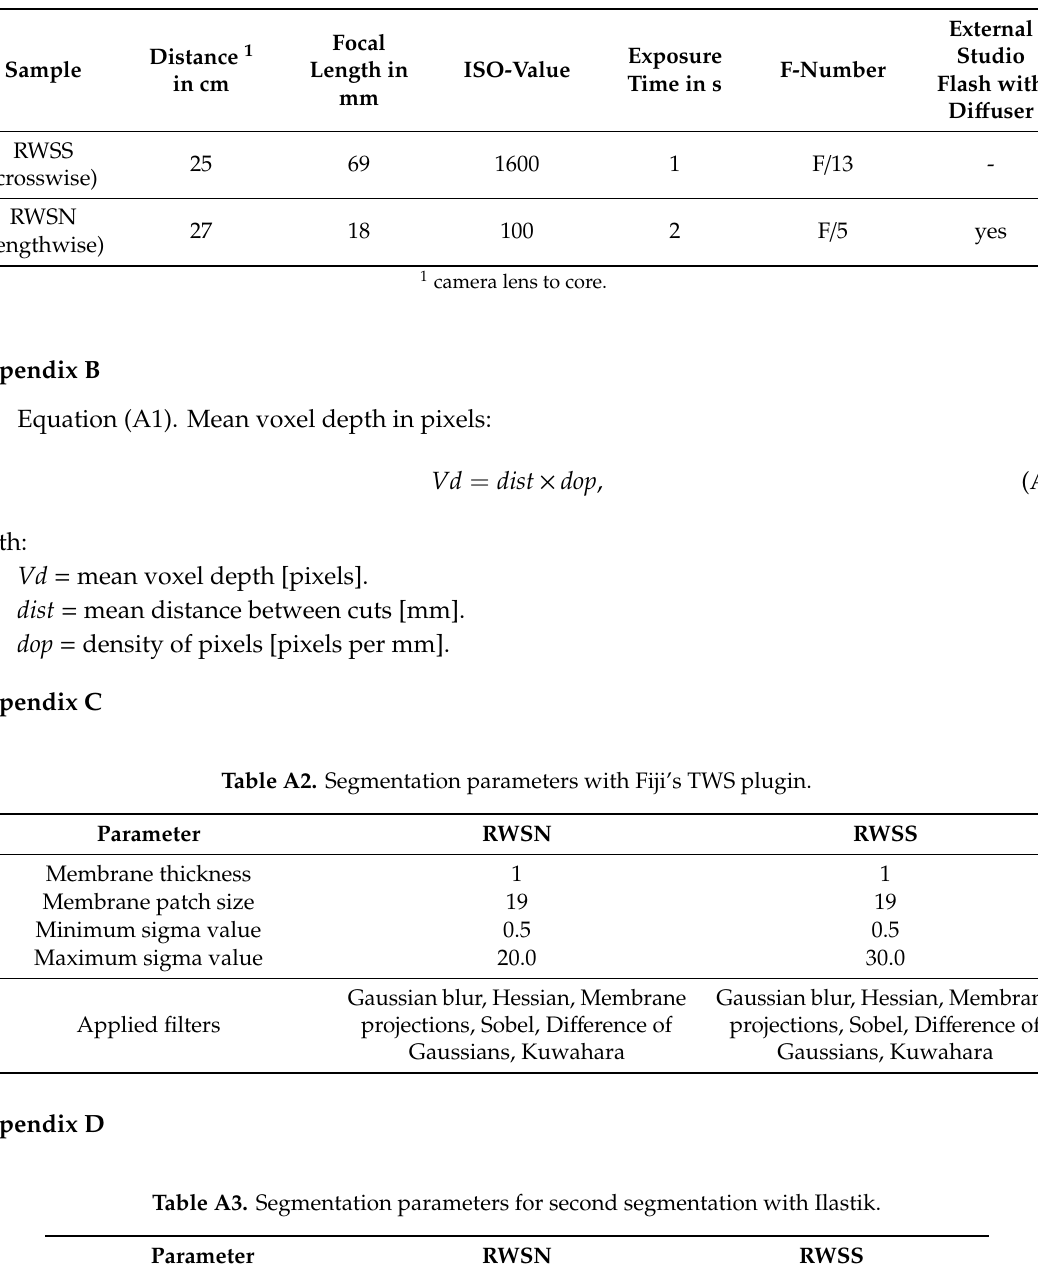
Table A1. Camera adjustments for lengthwise and crosswise cutting.